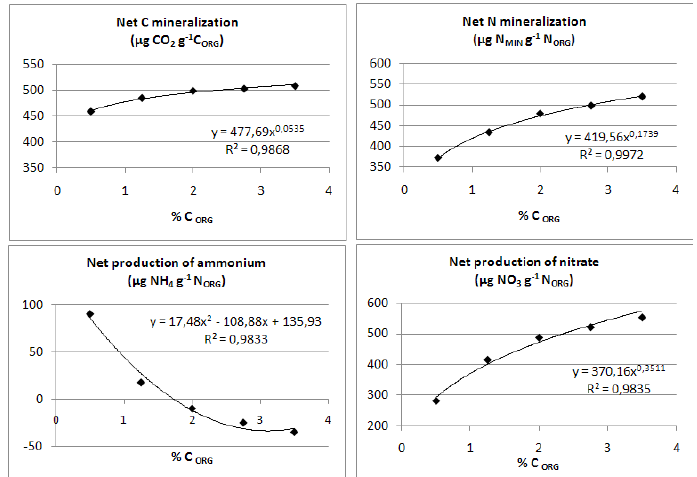
, easily hydrolizable N, N , 2 EH